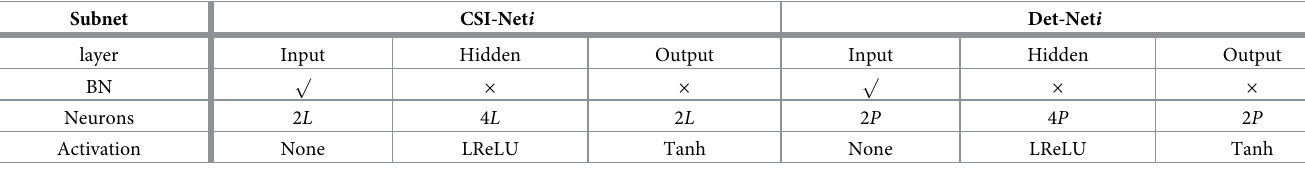
Table 1. Architecture of detection